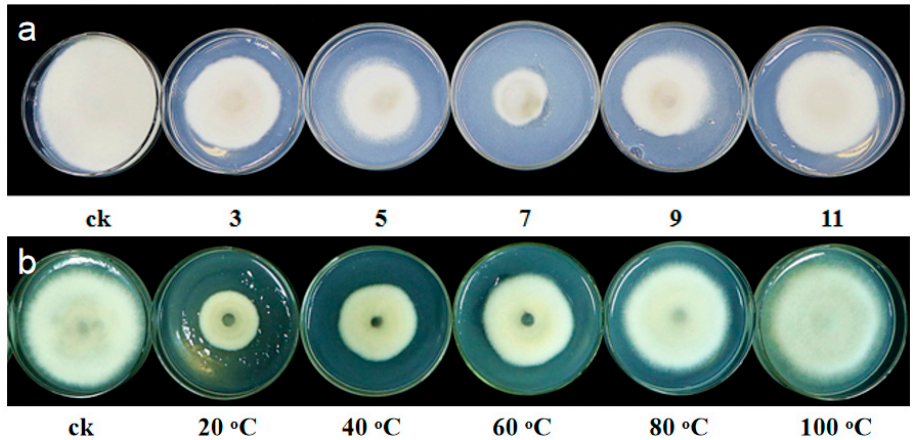
Figure 4. The effects of pH ( a ) and temperature ( b ) on the antifungal activity of the supernatant of NEAU-HV1 T .